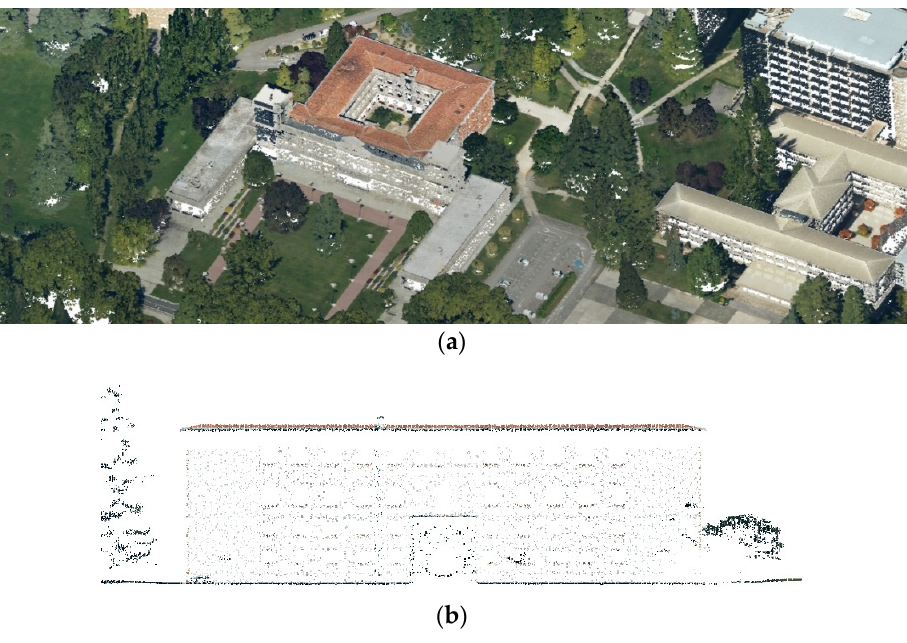
Figure 3. 2017 LiDAR cloud density: 14 points/m 2 . UNAV campus: ( a ) 3D detail of the central campus building; ( b ) north façade of the same